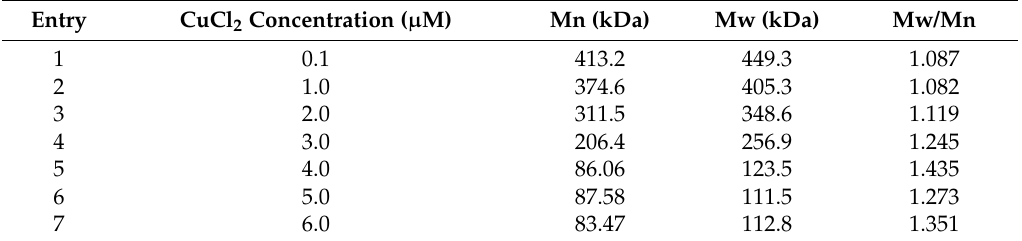
Table 2. Average molecular weights and dispersity indices of LMW-HA under different concentrations of copper ions.